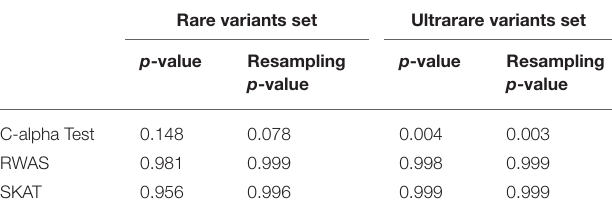
TABLE 4 | Results of burden tests in ALS patients and